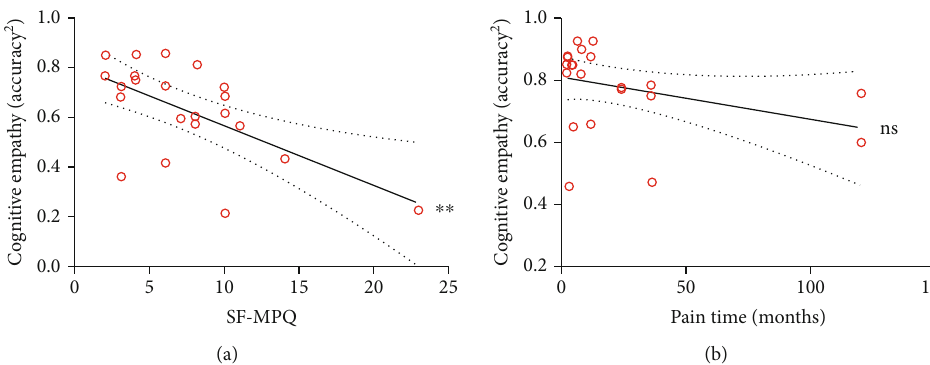
Figure 5: Correlations of SF-MPQ with squared cognitive empathy accuracy and pain duration. (a) Positive correlation between SF-MPQ and squared cognitive empathy accuracy. (b) No correlation between pain duration and cognitive empathy accuracy. The thick line indicates the regression line, and the dotted arcs indicate the con fi dence limits. ns: no signi fi cant; ∗∗ P < 0 : 01